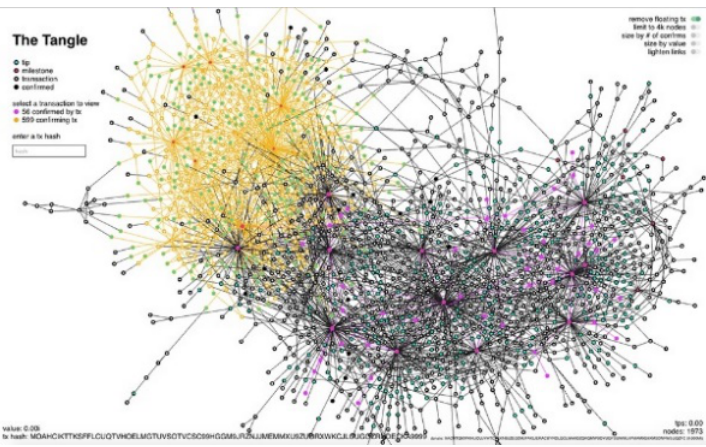
Figure 4. The Tangle live from